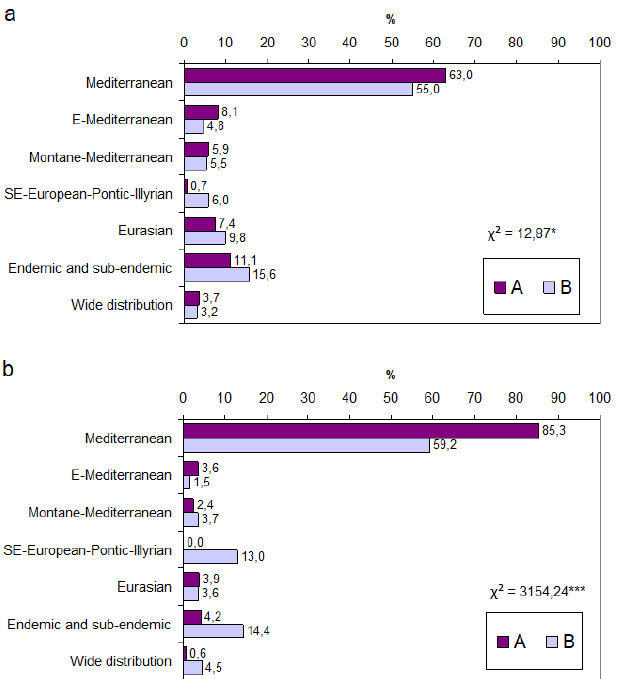
Figure 5. Chorological spectra weighted by frequency (a) and cover index (b) of the Satureja montana garrigues in Ionian Arc (A) and in Alta Murgia (B). * = p<0,05; *** =